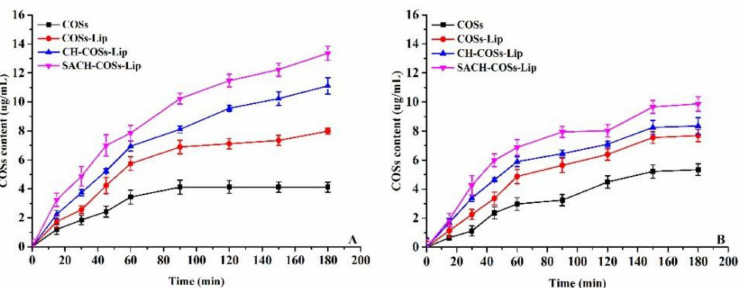
Figure 9. Time–effect relationship of COSs nano-liposomes transport on Caco-2 cells model. ( A ) From AP side to BL side. ( B ) From BL side to AP